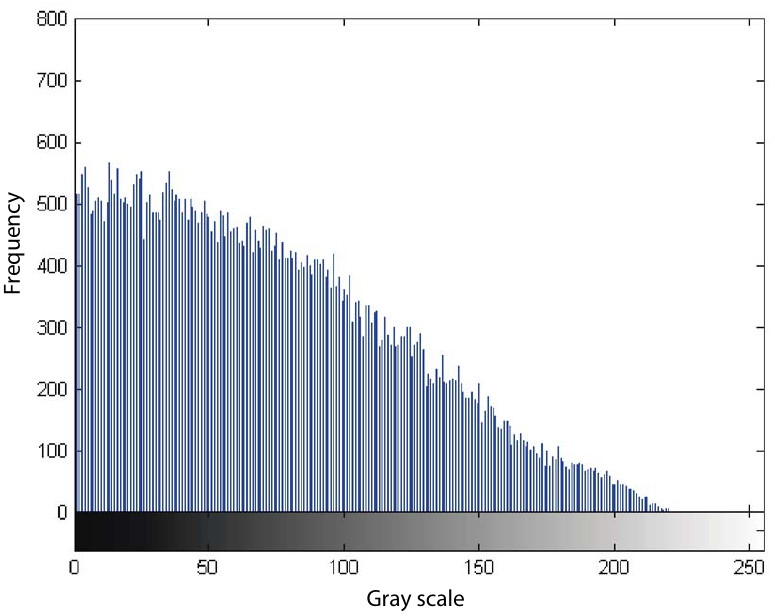
Figure 7. Histogram of the